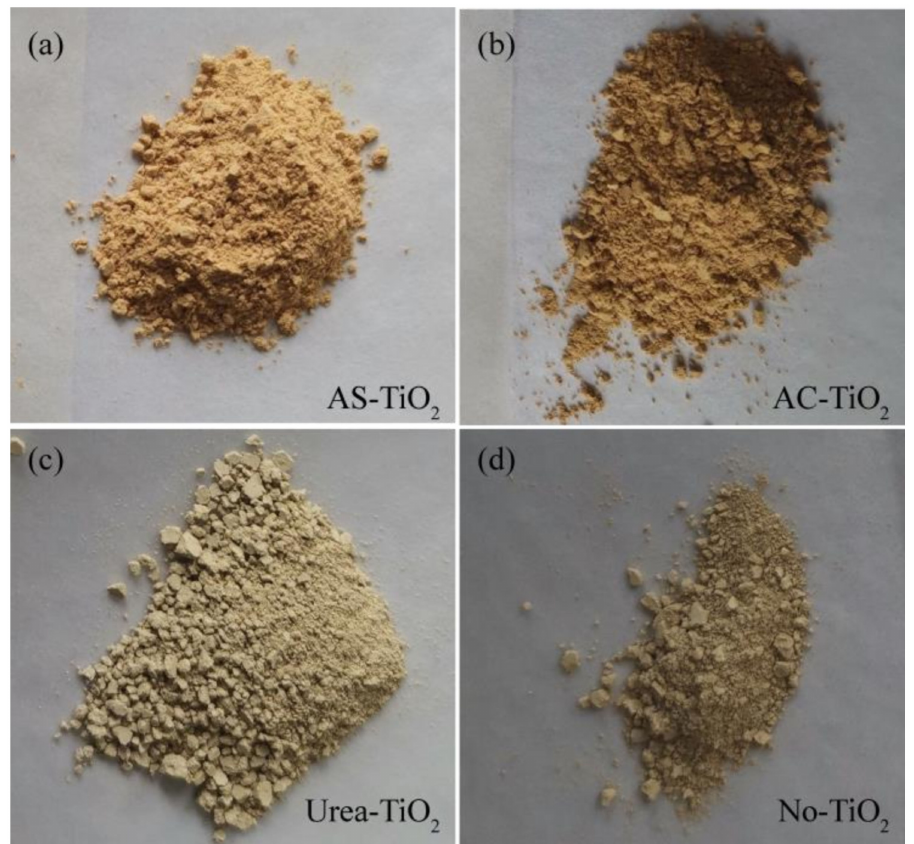
Figure 8. Photographs of the as-prepared ( a ) AS-TiO 2 ; ( b ) AC-TiO 2 ; ( c ) urea-TiO 2 ; ( d ) No-TiO 2 microcrystals in the presence and absence of shape-controlling